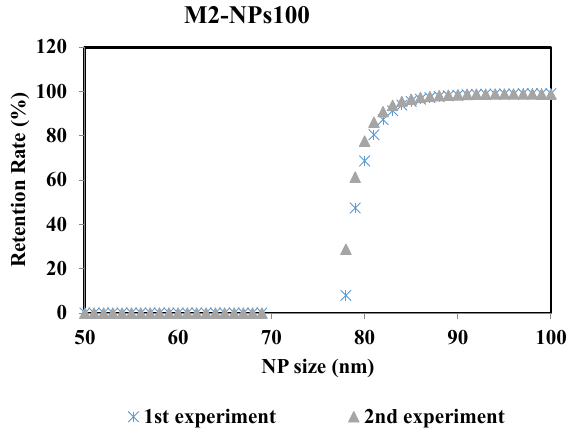
Figure 8. Retention rates of NPs 100 filtrated with membrane M2 of the two performed experiments: 1st and 2nd experiments carried out at same operating conditions.